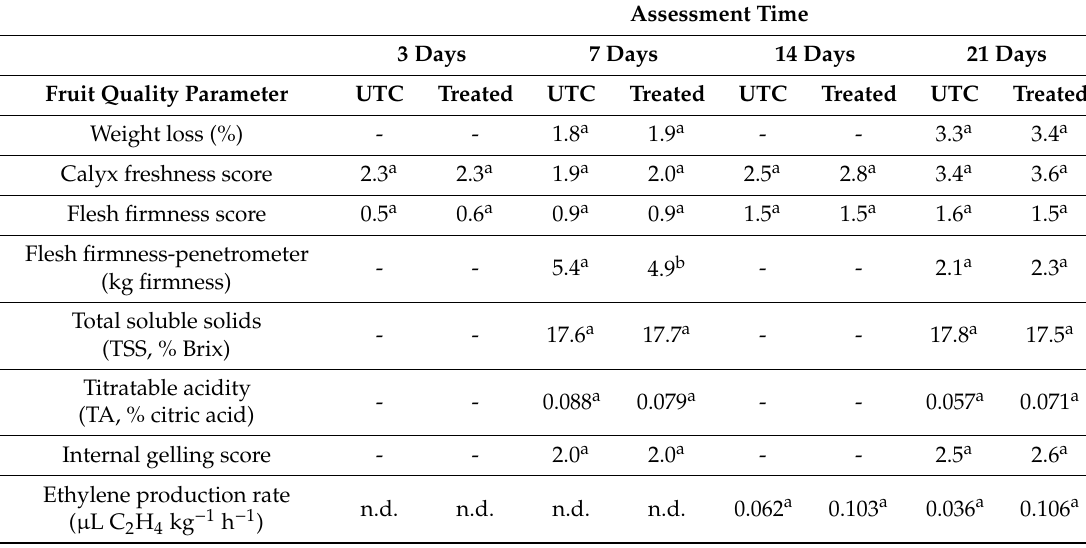
Table 1. E ff ect of irradiation treatment on ‘Jiro’ persimmon fruit quality during storage at 15 ◦ C for up to three weeks. Treatment comparisons are made within each assessment